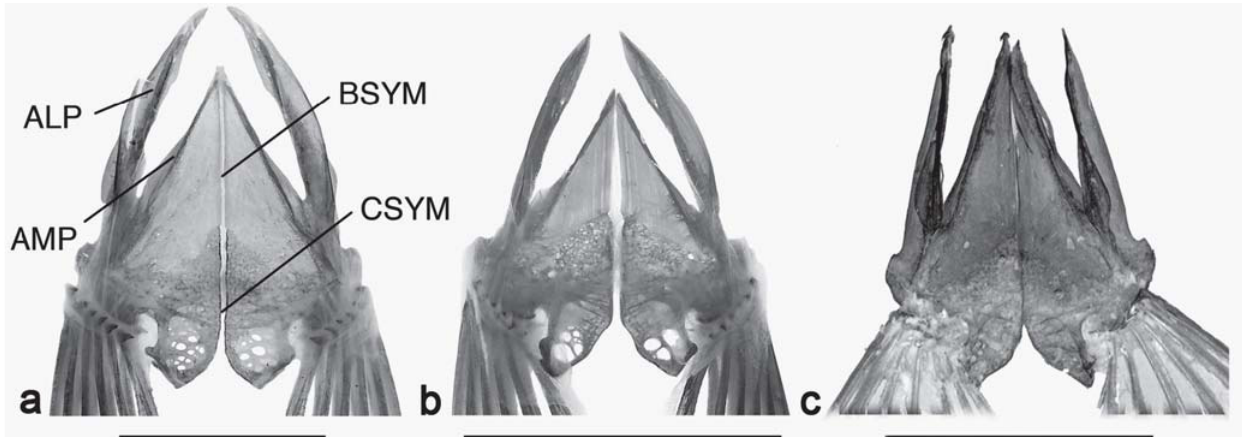
Fig. 6. Basipterygia bones of: a, Propimelodus caesius , ANSP 182256; b, Propimelodus eigenmanni , ANSP 178505; c, Propimelodus araguayae , INPA 26121. Scale bar = 10 mm. ALP = anterior lateral process, AMP = anterior medial process, BSYM = membrane bone symphysis, CSYM = synchondral symphysis. Pictures of P. eigenmanni and P. caesius from Parisi et al ., 2006